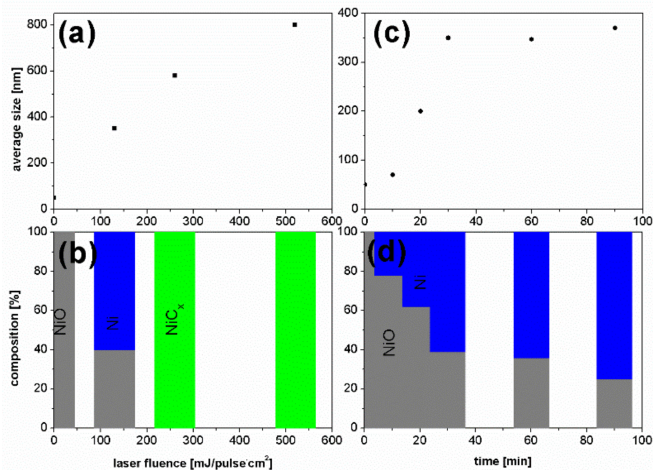
Figure 3. Dependence of particle ( a ) size and ( b ) phase changes on the laser light fluence (1 h of irradiation). Dependence of particle ( c ) size and ( d ) phase changes on irradiation time (130 mJ/pulse · cm 2